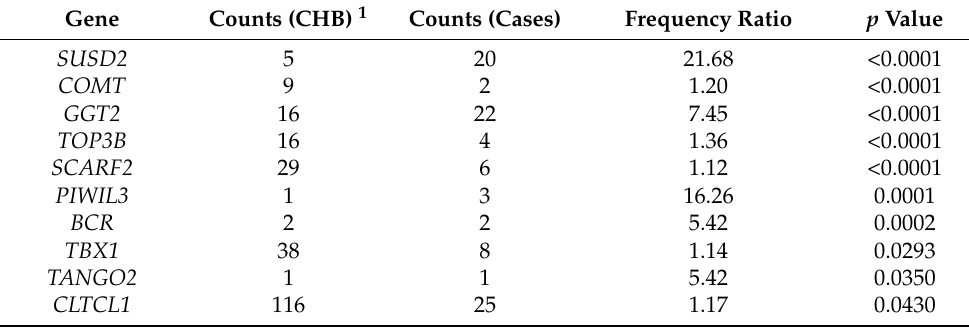
Table 2. Gene-based association between cases and CHB.